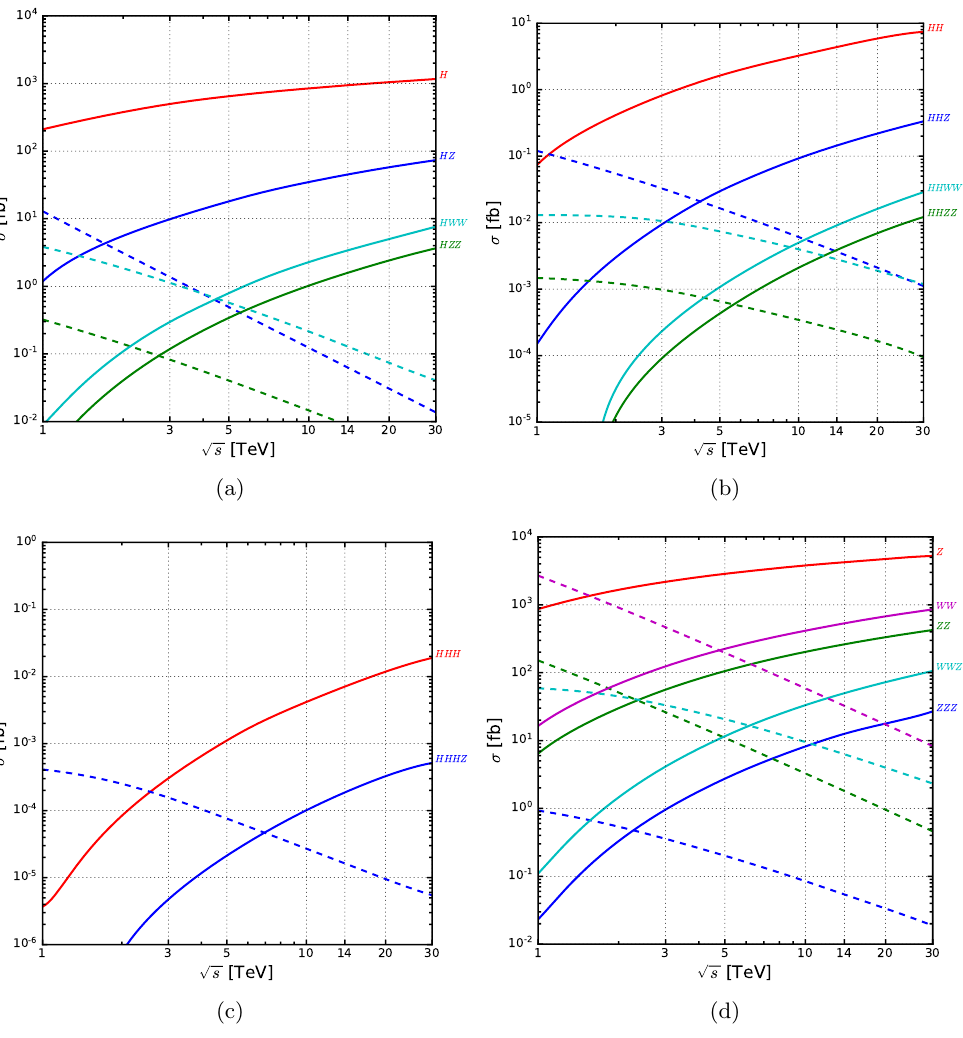
Figure 4 . Same as (cid:12)gure 3 but for (a) HX , (b) HHX , and (c) HHHX associated production as well as (d) multiboson